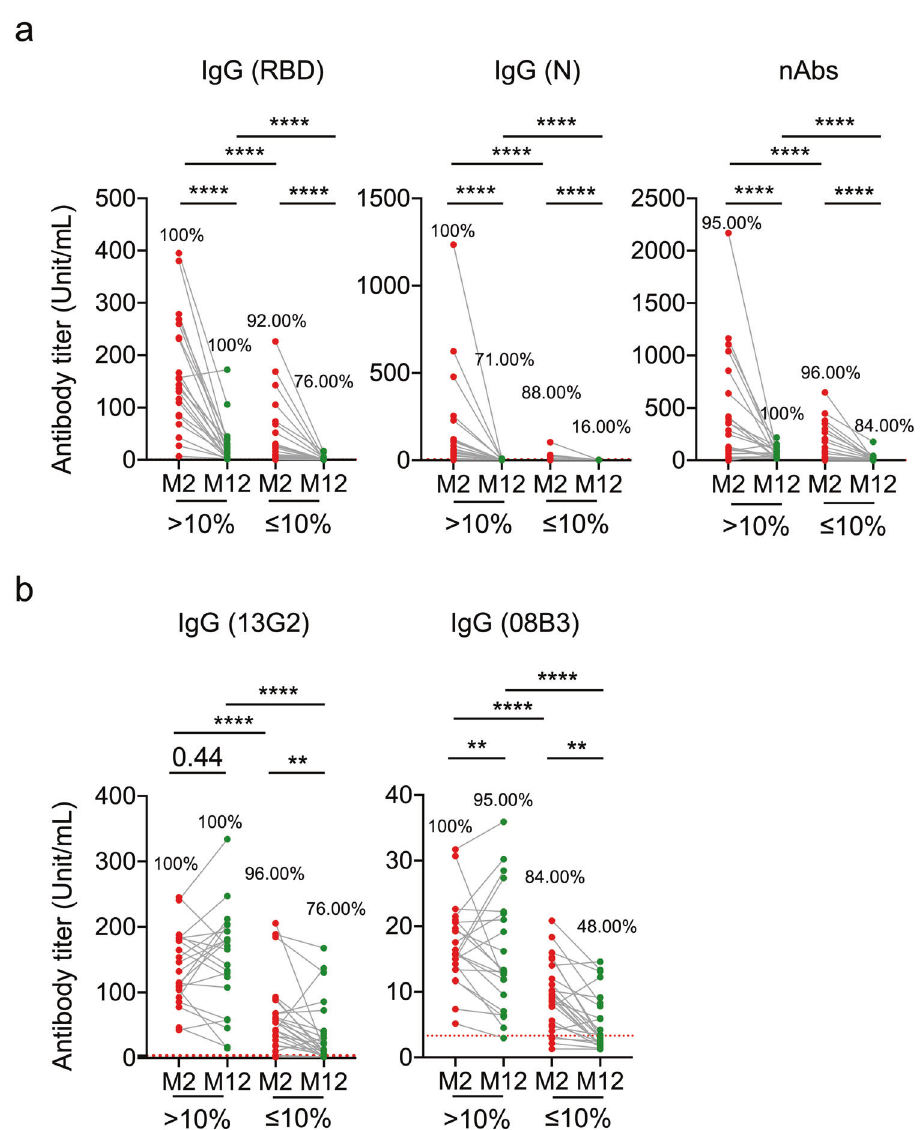
Fig. 3 High levels of virus-speci fi c CD4 + T cell at early convalescent phase correlate with long-term maintenance neutralizing antibodies. Antibodies present in plasma of the high- ( n = 23) and low-CD4 + groups ( n = 23) against RBD and N, and nAbs in the plasma at M2 and M12, were examined using ELISA and FRNT 50 assays. a , b Pair comparisons of IgG levels against RBD and N and nAbs between M2 and M12 for the high-and low-CD4 + groups; b Pair comparisons of IgG levels against the 13G2 and 08B3 clusters. Percentages on top of dot plots represent frequencies of samples with antibody titers above the cutoff. Each dot represents an individual participant. ** p < 0.01 and **** p < 0.0001. Student ’ s t -test was used to analyze differences in the mean values between groups. The Mann – Whitney test was used to compare the central tendencies of the two groups (mean or median). Wilcoxon rank-sum test was used to compare paired continuous variables that were not normally distributed. The percentage above the dot plots indicates the detection rate of each